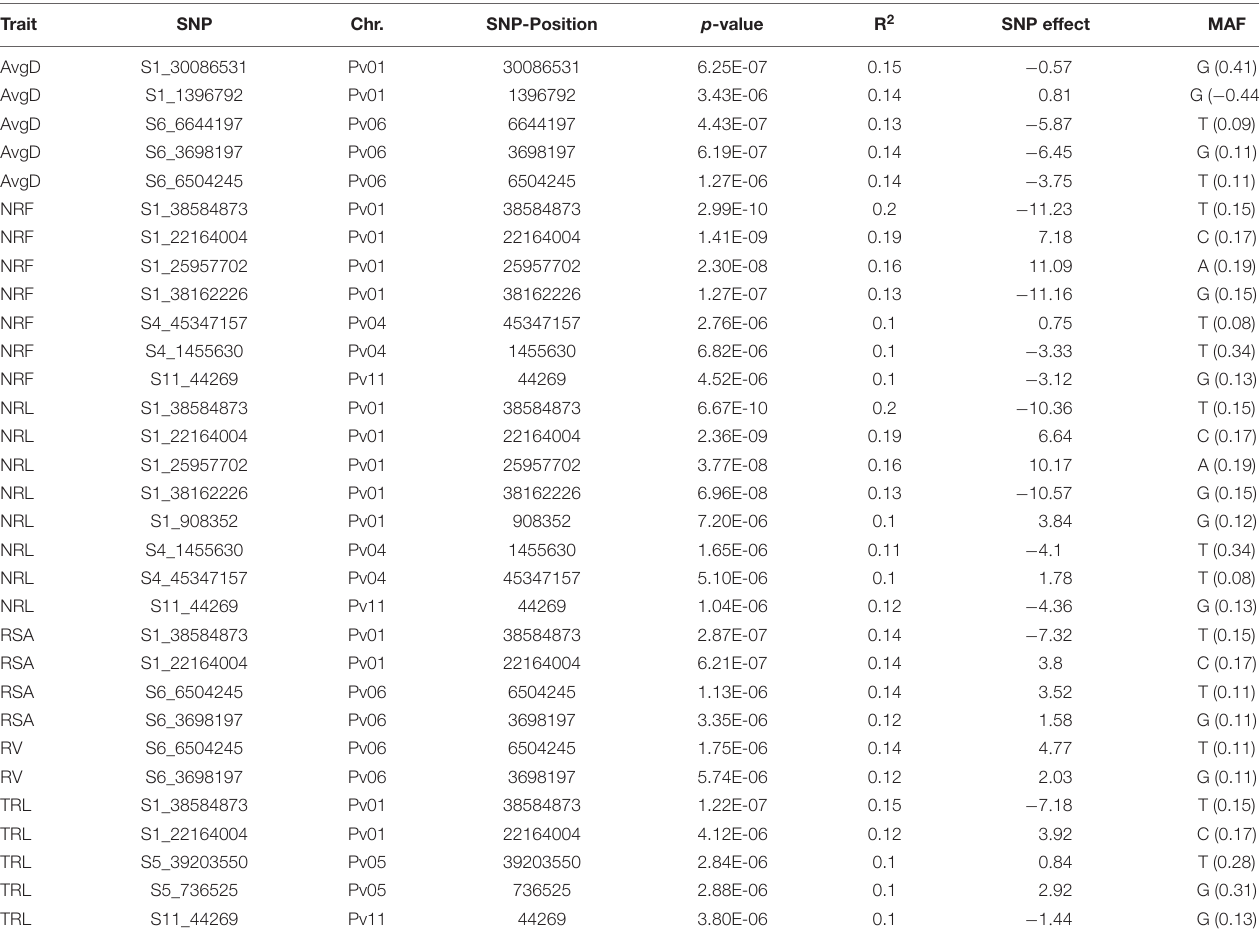
TABLE 2 | List of significant SNP markers detected for root traits evaluated for the common bean Andean Diversity Panel (ADP) showing physical position, association level ( p -value), phenotypic variation (R 2 ) explained by the locus, additive SNP effect and minor allele frequencies (MAF). Trait SNP Chr. SNP-Position p -value R 2